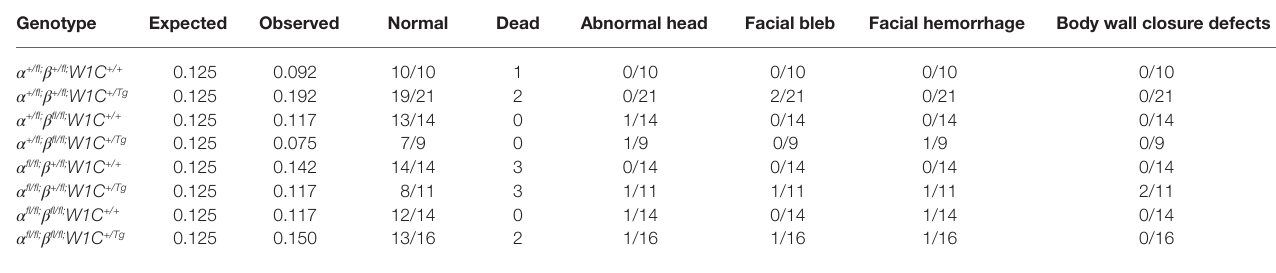
TABLE 1 | Phenotypes of E10.5 embryos from intercrosses of Pdgfra fl/fl ; Pdgfrb fl/fl mice with Pdgfra +/fl ; Pdgfrb +/fl ; Wnt1-Cre +/Tg mice. Genotype